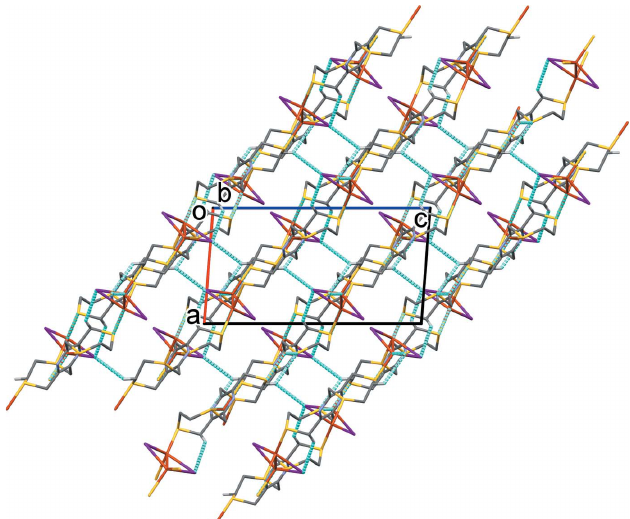
Figure 3 A view along the b axis of the crystal packing of complex I . Hydrogen bonds are shown as dashed lines (Table 1). For clarity, only the hydrogen atoms involved in these interactions have been